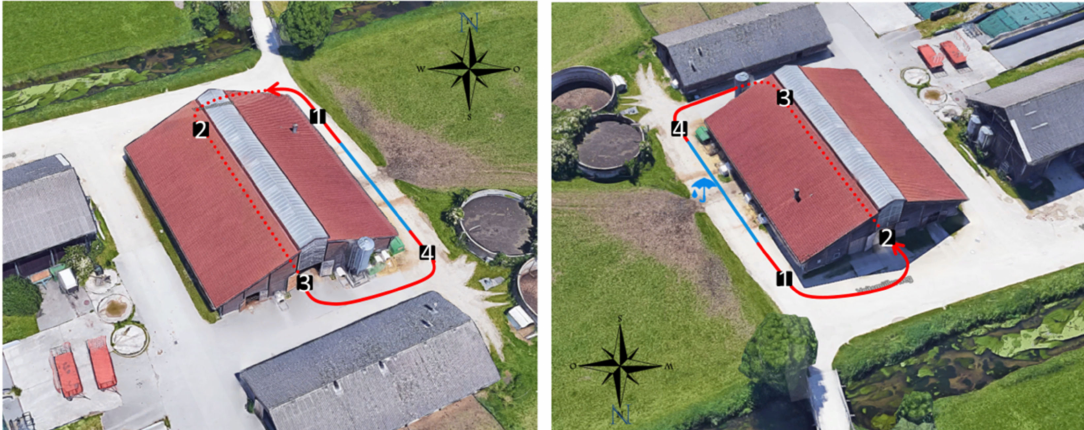
Figure 5. The route with marks 1 to 4. The route of the robotic vehicle did not change during the runs. Only the starting point has been relocated. (Scale 1:10)